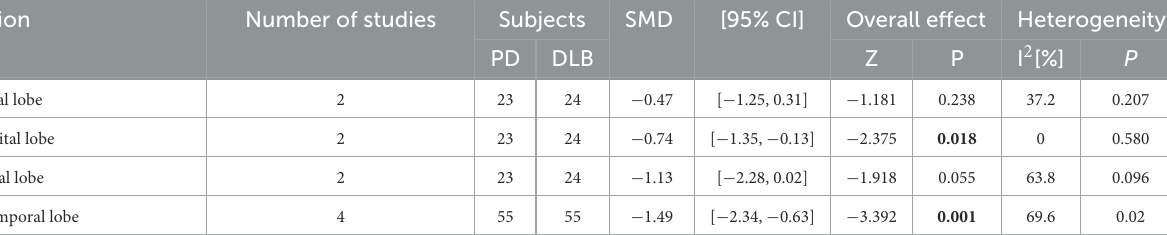
TABLE 9 Random effects meta-analyses result between PD and DLB subjects. Region Number of